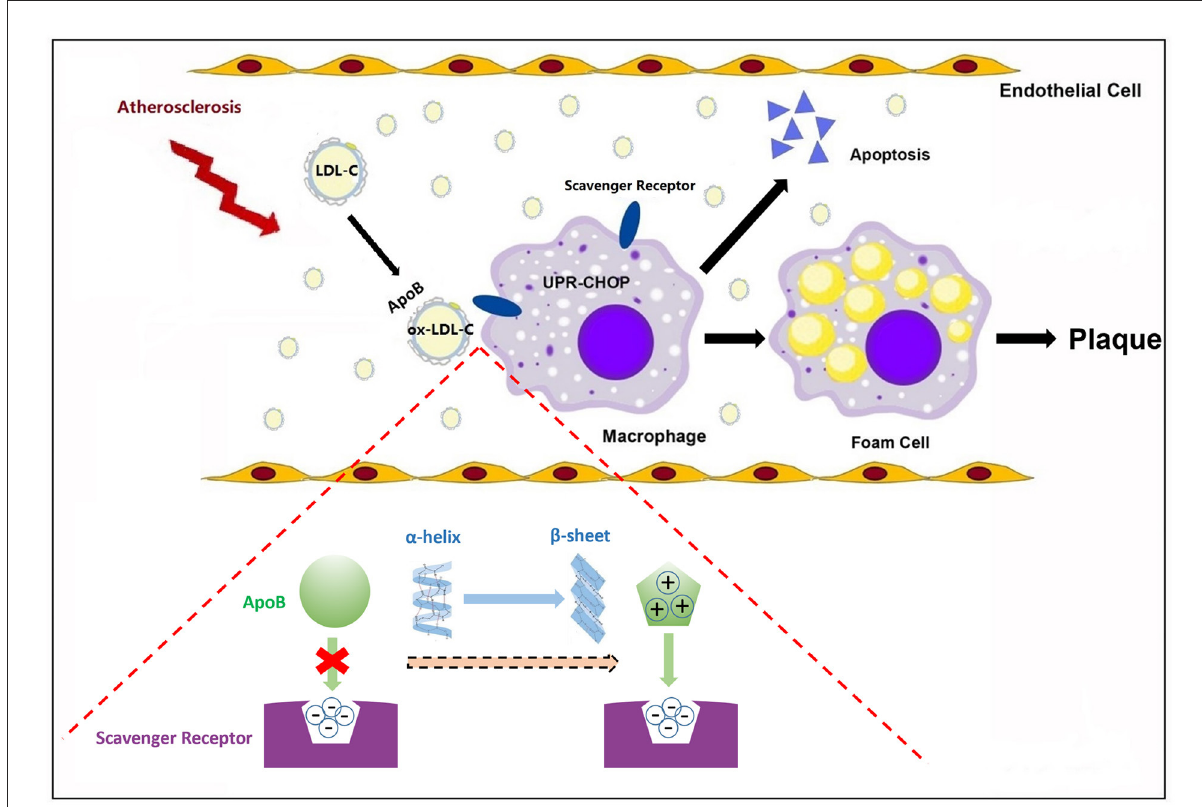
FIGURE3 β -sheet conformational change of apolipoproteins in atherosclerosis. In atherosclerosis, the α 2 domain of ApoB transforms from α -helix to β -sheet. The β -sheet may not only form a positively charged ligand structural domain but also a structurally complementary spatial